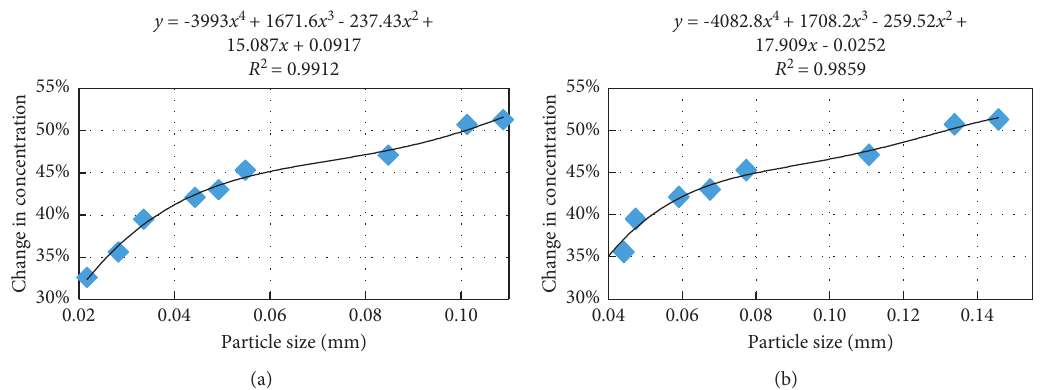
Figure 4: Nonlinear relation between particle size of tailings and change in concentration. (a) Median particle size of tailings. (b) Control particle size of tailings.